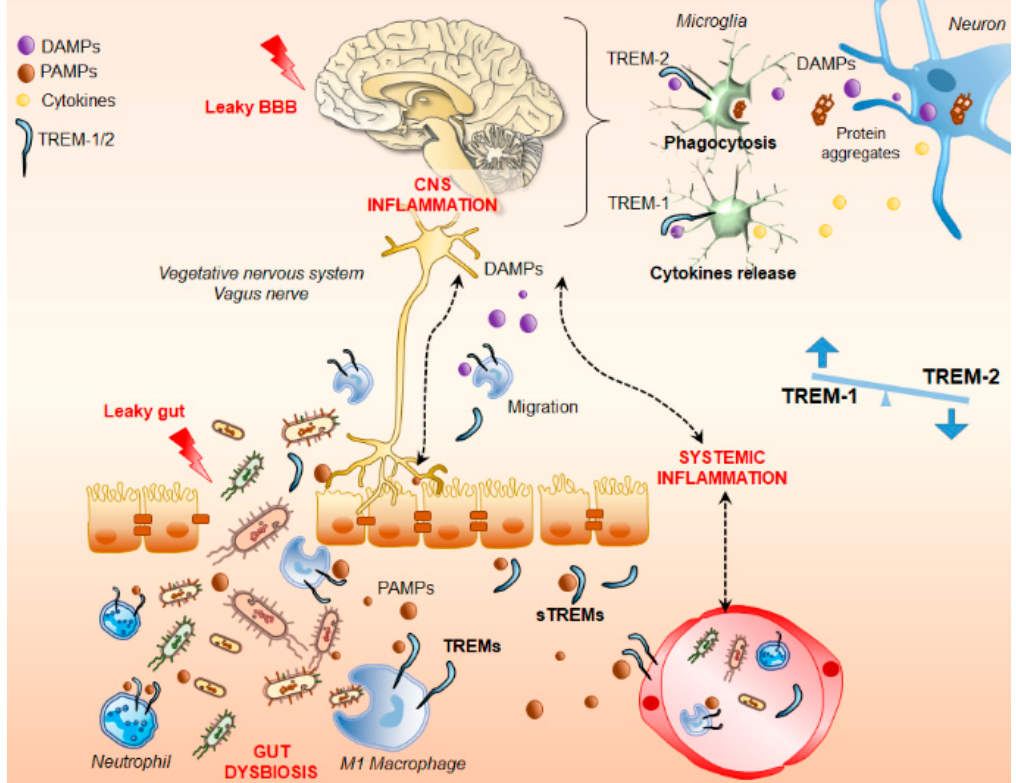
Figure 2. Triggering Receptors Expressed on Myeloid cells ( TREMs) spreading inflammation through the gut-brain-axis. In conditions of dysbiosis, compounds released by intestinal bacteria (Pathogen- associated Molecular Patterns, PAMPs) activate TREMs on macrophages and neutrophils leading to an exuberant pro-inflammatory reaction up to damage in the gut barrier. TREM-positive activated macrophages/monocytes, along with cytokines, PAMPs, microbes, and soluble TREMs may reach the brain through the blood, circumventricular organs, or the vagus nerve through the microbiota-gut-brain axis. This leads to a systemic inflammatory response which, in turn, impairs the blood-brain barrier and promotes neuroinflammation and, ultimately, neural injury and degeneration. In this context, besides being transported within the central nervous system (CNS) through infiltrating immune cells, TREMs are also activated in microglia by Danger Associated Molecular Patterns (DAMPs) being released by damaged neurons along with protein aggregates. This leads on the one hand to microglial phagocytosis by TREM-2, and on the other hand, to the amplification of the inflammatory response exacerbating both CNS and systemic inflammation through TREM-1-dependent cytokine production.